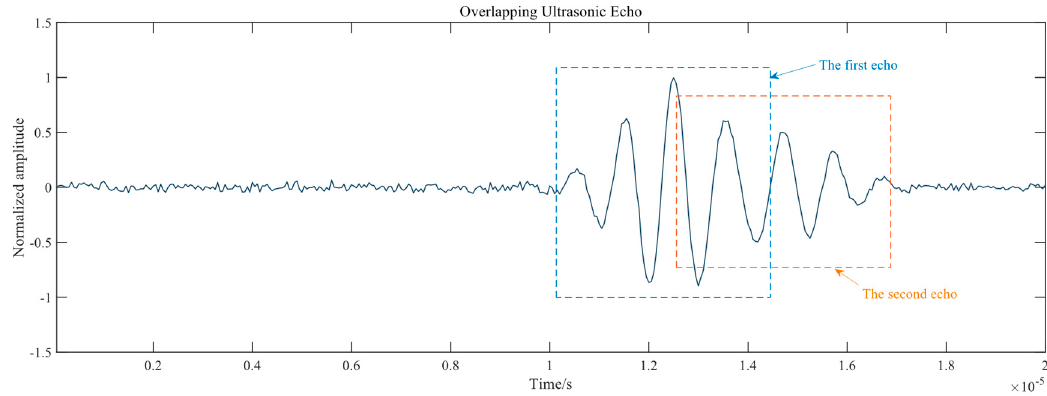
Figure 2. Overlapping ultrasonic echo acquired where the thickness of pipeline is too thin.